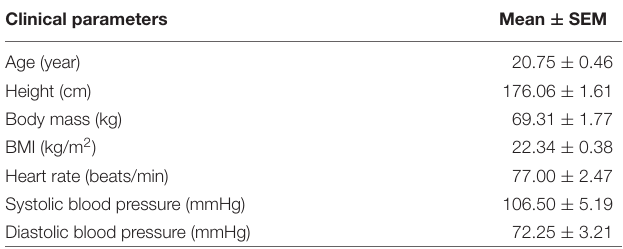
TABLE 1 | Clinical characteristic of participants.